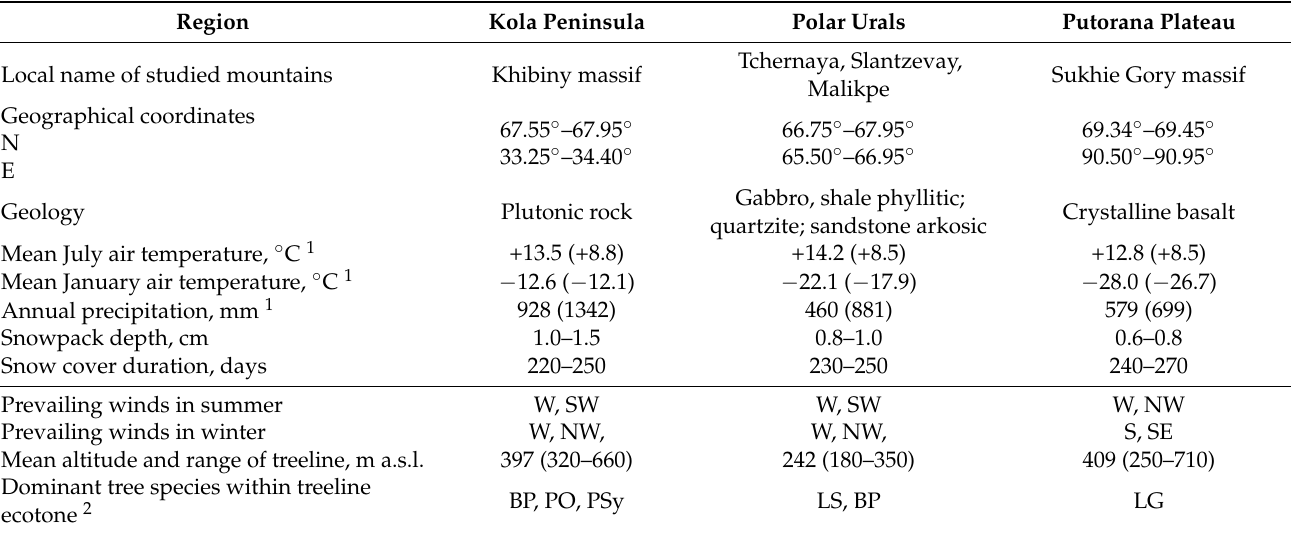
Table 1. General information on the target